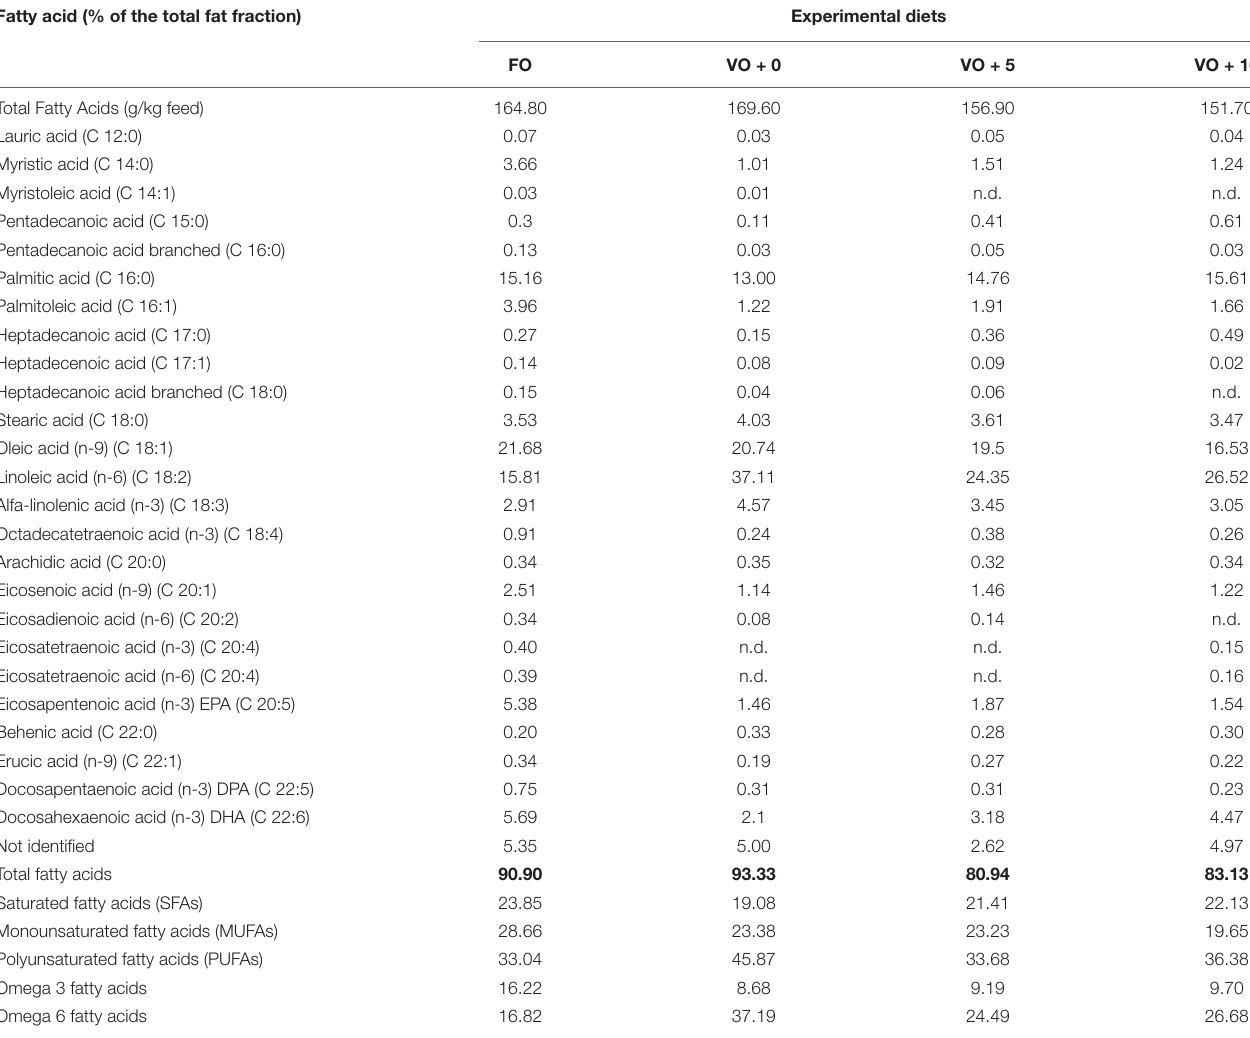
TABLE 3 | Total fatty acid content and fatty acids profile of the four different experimental diets. Fatty acid (% of the total fat fraction)